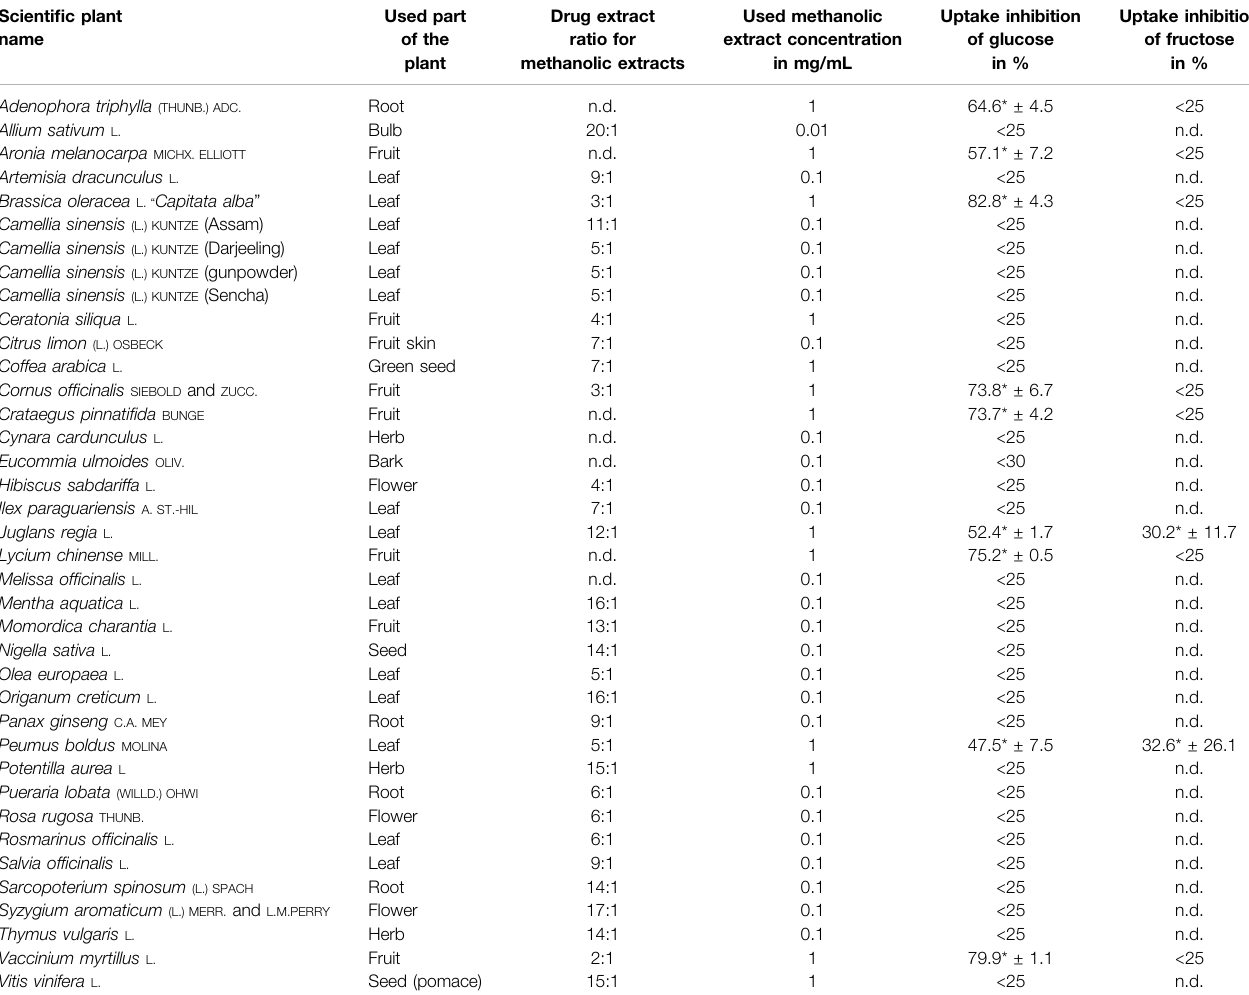
TABLE2| Resultsofglucoseandfructoseuptakestudieswithmethanolicextracts,theusedplantpart,drugextractratio,andtestedconcentration,whichdidnotshowany in fl uence on cells in MTT assay. Only the plants that showed the strongest inhibition rates on glucose uptake were tested for fructose uptake inhibition. Regarding methanolicandaqueousextracts,theextractofaplantthatshowedthestrongerinhibitiononglucoseabsorptionwasrepeatedandtestedforitsimpactonfructoseuptake; mean value ± SD; *signi fi cant difference in U -test ( n (cid:1) 2 with 12 replicates each; two-sided; α (cid:1) 0.05); n.d. (cid:1) not determined. Scienti fi c plant name